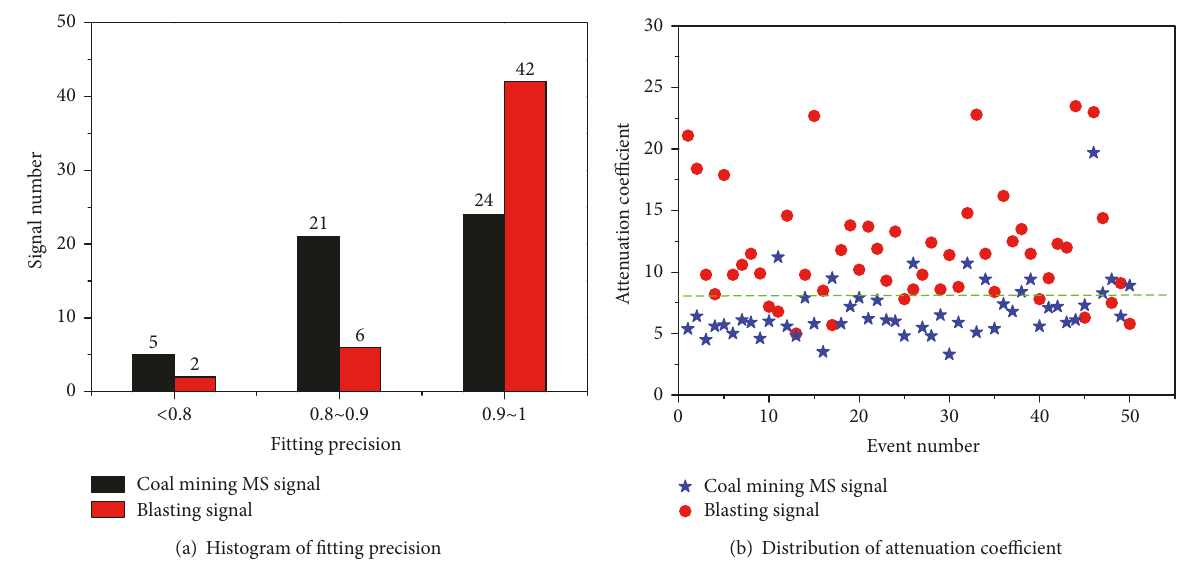
Figure 7: Distribution of fitting precision and attenuation coefficient of all the